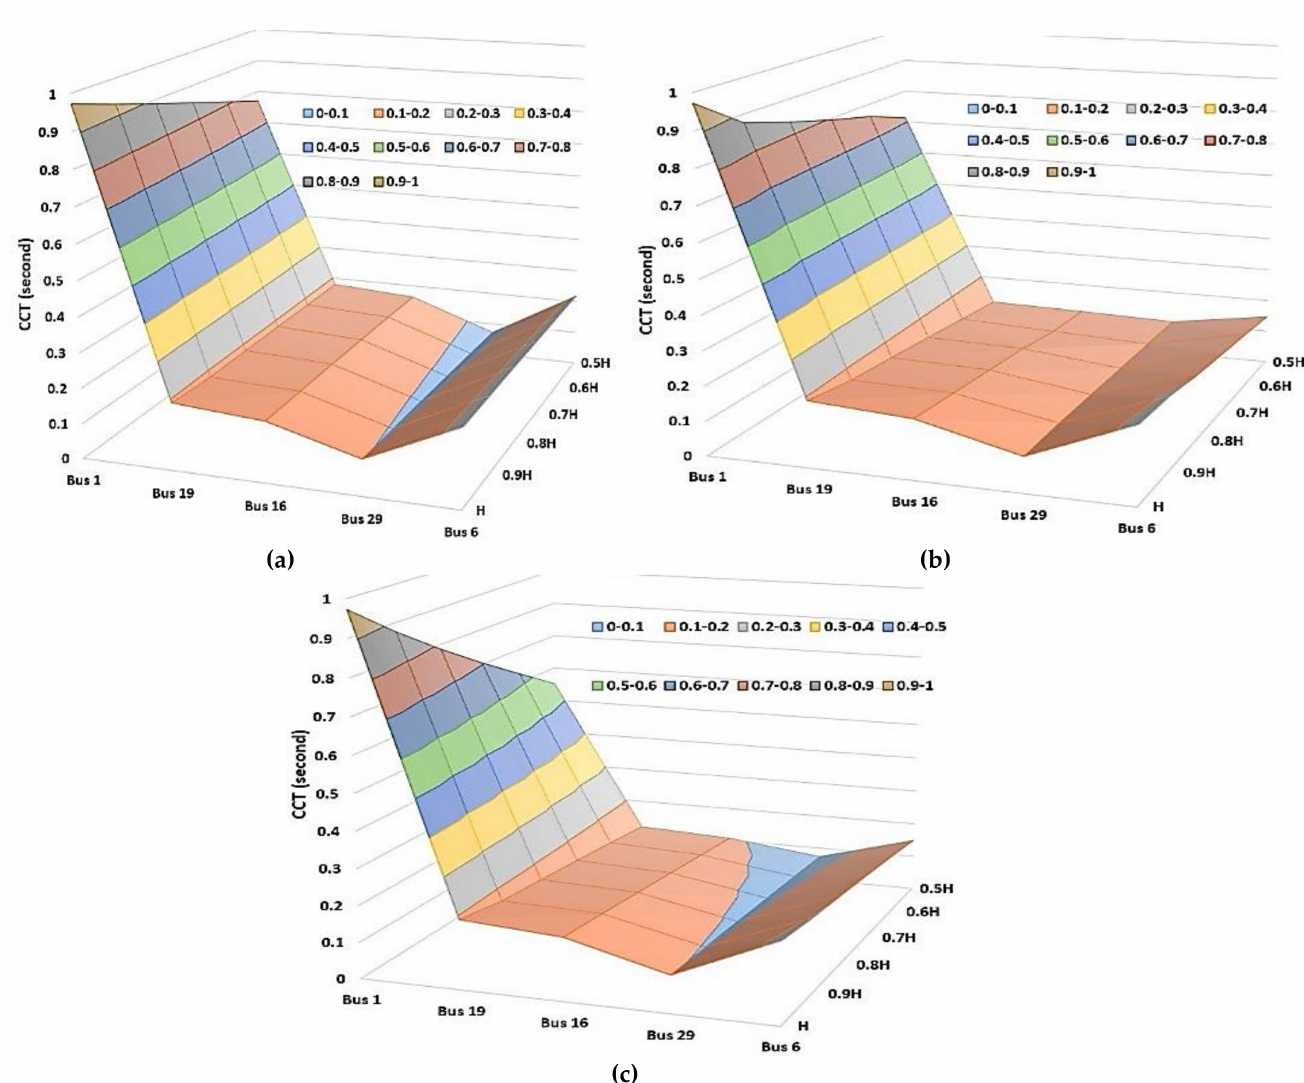
Figure 3. Sensitivity analysis of inertia constant with the CCTs at buses for three scenarios ( a ), ( b ) and ( c